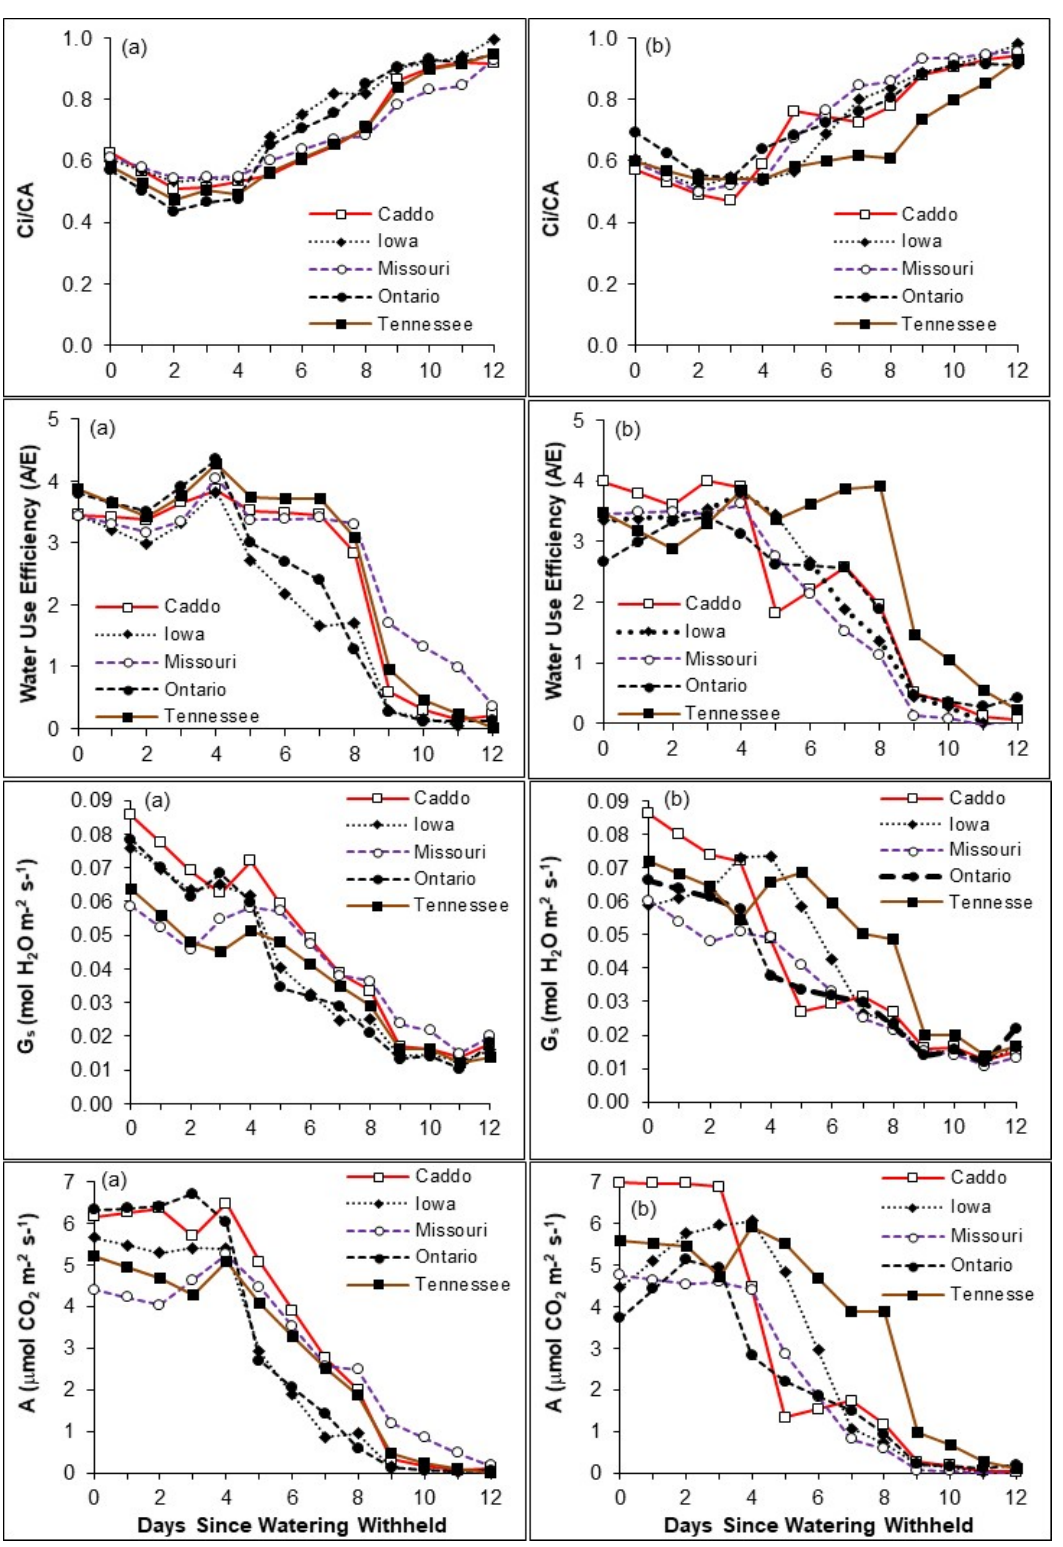
Figure 2. Daily changes in net CO 2 assimilation (A), stomatal conductance to (G s ), instantaneous water use efficiency (WUE), and intercellular to ambient CO 2 concentrations (Ci/Ca) in 10-week-old Acer saccharum subsp. saccharum and Acer saccharum subsp. nigrum (Iowa) seedlings, preconditioned during the last 7-weeks under ( a ) dry or ( b ) moist regime and then subjected to no watering over 12 days.